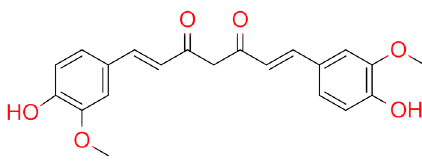
Figure 3. Chemical structures of curcumin.